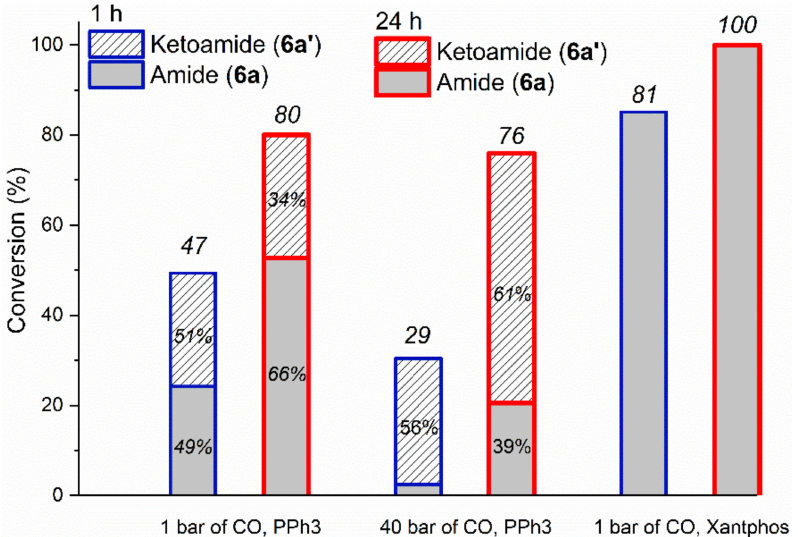
Figure 2. Conversion of 6 in the presence of b as a function of carbon monoxide pressure and the ligand used during the aminocarbonylation in DMF in 24 h